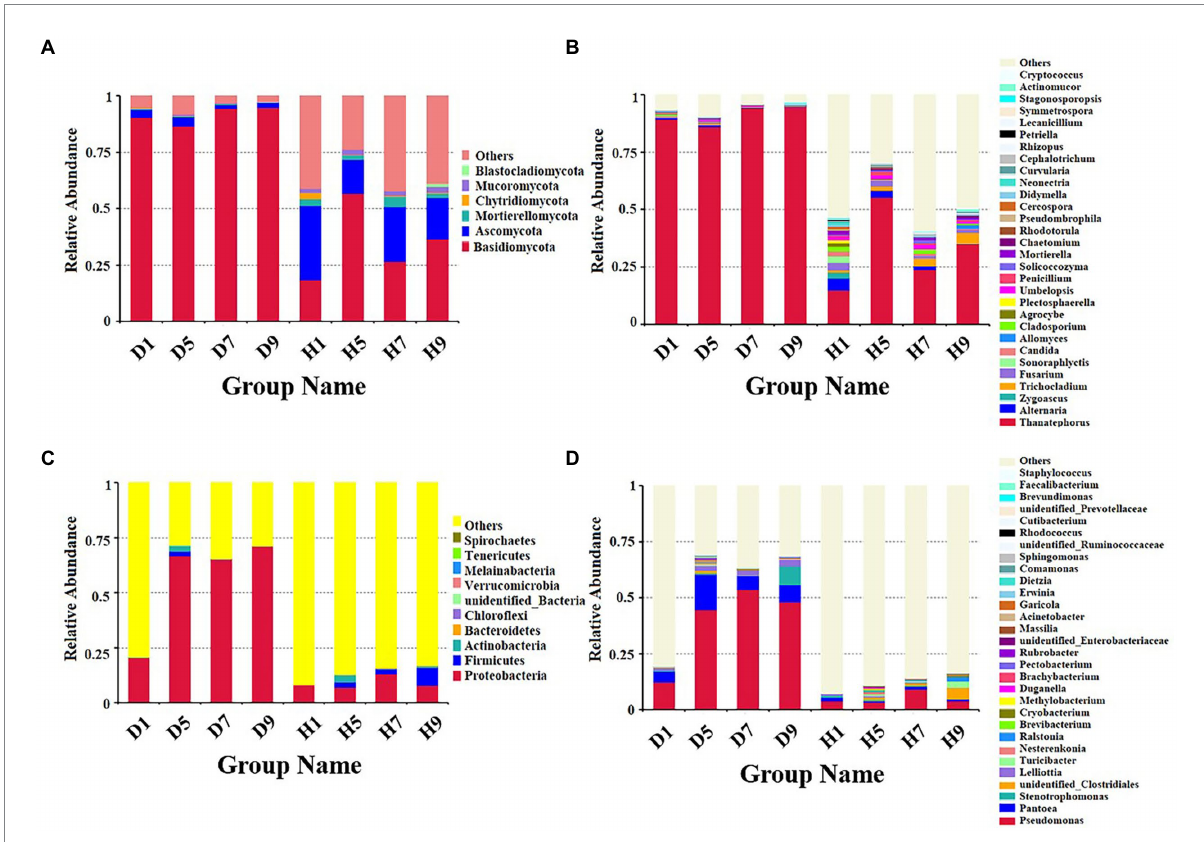
FIGURE 4 Microbial community composition of different groups at the phyla and genus levels. Fungal community composition of different groups at the phyla (A) and genus (B) levels. Bacterial community composition of different groups at the phyla (C) and genus (D)